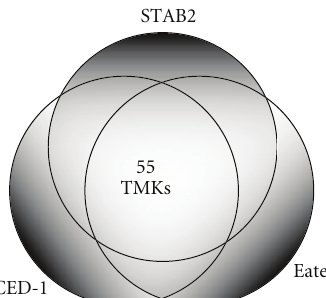
Figure 2: Venn diagram summarizing results of Entamoeba his- tolytica BLAST searches using the extracellular domains of CED- 1 ( C. elegans ), eater ( D. melanogaster ), and STAB2 ( H. sapiens ). Fifty-five members of the E. histolytica transmembrane kinase gene family share significant homology to these representative scavenger receptors.